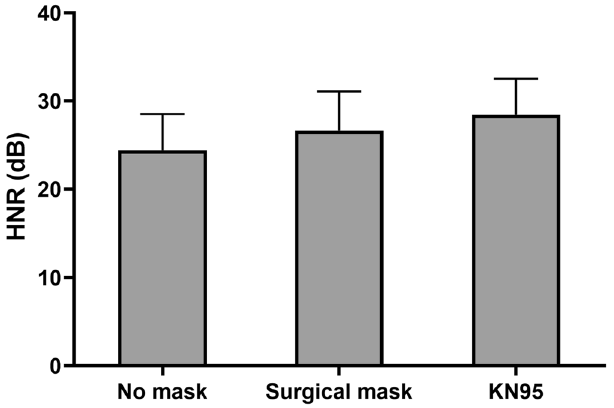
Figure 4. Harmonics-to-noise ratio in all conditions. Error bars = standard deviation.